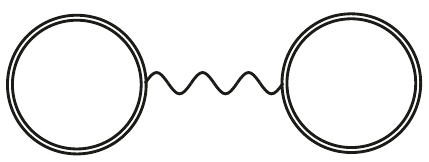
Figure 2 . The 1PR contribution to the two-loop EHL: the \dumbell" diagram, consisting of two tadpoles sewn together. The double lines indicate the particle propagators dressed to all orders by the background